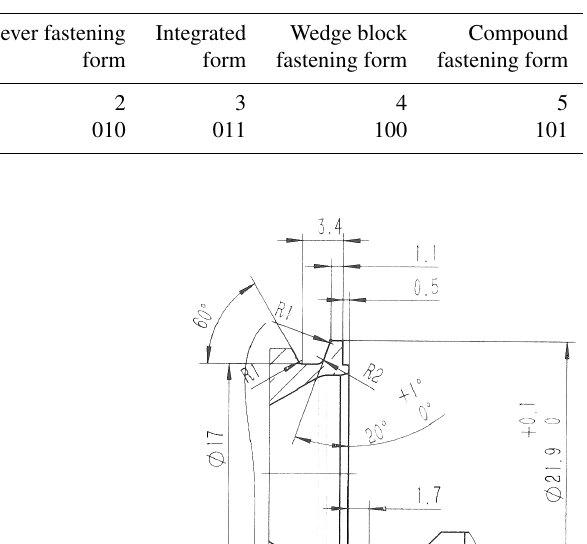
Table 5. Discrete attribute clamping method X 2 .